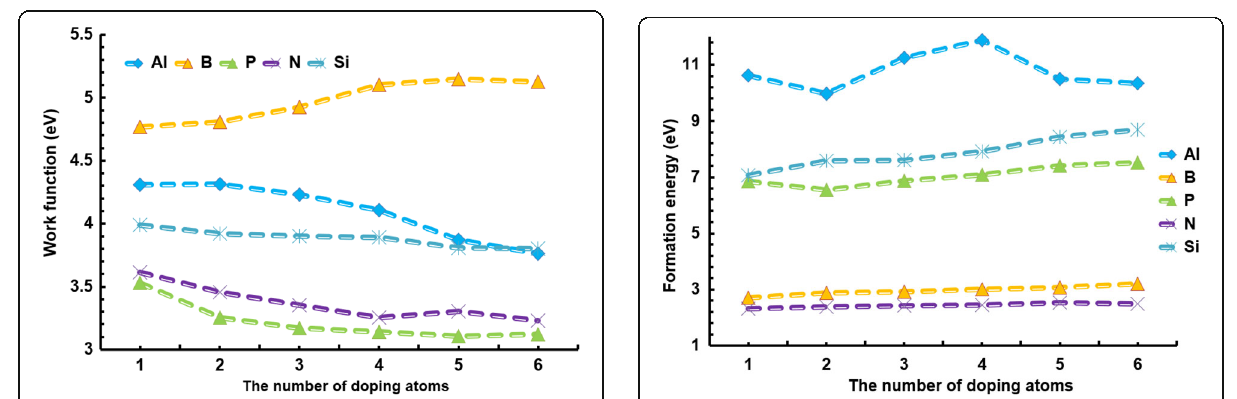
Fig. 4 The relationship between the WF and the number of doping atoms. The relationship between the WF and the number of doping atoms. Different types of dopants, e.g., Al, B, P, N, and Si, are doped in the graphene with the size of 4 × 4 cells